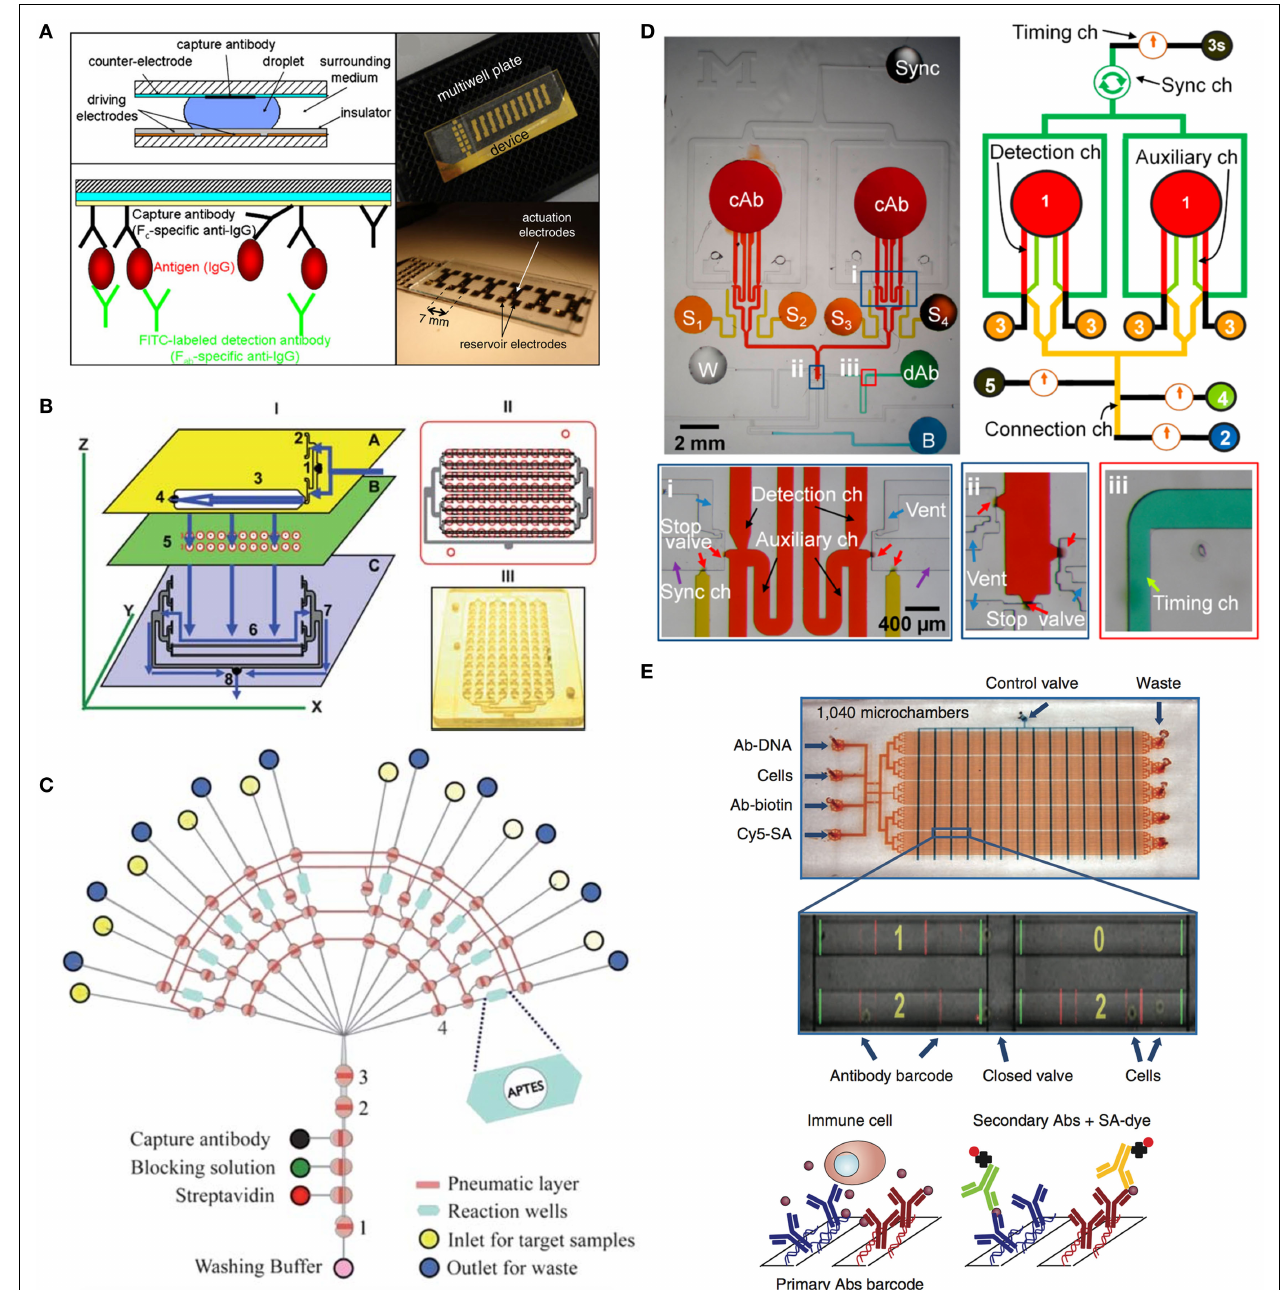
FIGURE 5 | Facilitated automated immunoassay on chip . (A) A digital microfluidic (DMF) device by Miller and Ng (2011) was applied to a heterogeneous sandwich immunoassay. The digital approach to microfluidics manipulates samples and reagents in the form of discrete droplets, as opposed to the streams of fluid used in microchannels. DMF devices are straightforward to use, and are reconfigurable for any desired combination of droplet operations. This flexibility makes them suitable for a wide range of applications, especially those requiring long, multistep protocols such as immunoassays. Reprinted from Miller and Ng (2011) with permission of Springer Science + Business Media. (B) Schematic representation of the 96-well ELISA-LoC system developed by Sun et al. (2010) requires only 5 μ l of sample and in the combination with a CCD camera allows low-cost immunodetection without laboratory environment. Reproduced from Sun et al. (2010) by permission of The Royal Society of Chemistry. (C) The microfluidic device by Kim et al. (2011) for solid-phase immunoassays based on microparticle labeling was developed using microvalve-control structures for automated sample processing. Programmable microvalve control in a multilayer structure provides automated sample delivery, adjustable hydrodynamic washing, and compatibility with a wide range of substrates. Reproduced from Kim et al., 2011 by permission of The Royal Society of Chemistry. (D) Capillarity-driven immunoassay device for sequential and parallel flow processing greatly saving time and labor with an inexpensive setup developed by Kim and Paczesny (2013). Reprinted with permission from American Chemical Society. (E) Design of the SCBC for single-cell protein secretome analysis developed by Ma et al. (2011). In their design flow, channels are shown in red and the control channels are shown in blue. An optical micrograph (zoomed picture) shows the loaded cells isolated within the microchambers, overlaid with the fluorescence micrograph of the developed assay barcode for those same microchambers. Reprinted by permission from Macmillan Publishers Ltd: Nature Medicine, Ma et al. (2011).